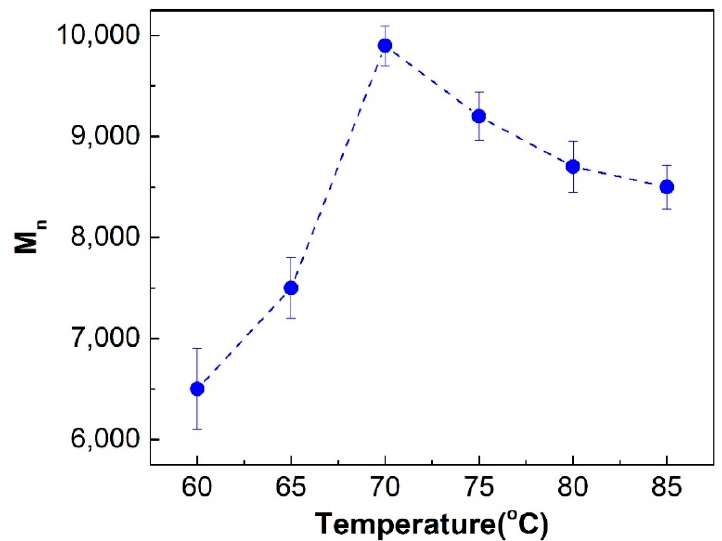
Figure 7. The effect of reaction temperature on molecular weight of PAM. The plot of M n vs. polymerization time. Polymerization conditions: [M] 0 , 12%; [M] 0 /[CTA] 0 /[AIBN] 0 , 200/1/0.1; temperature range, 60 °C to 85 °C.